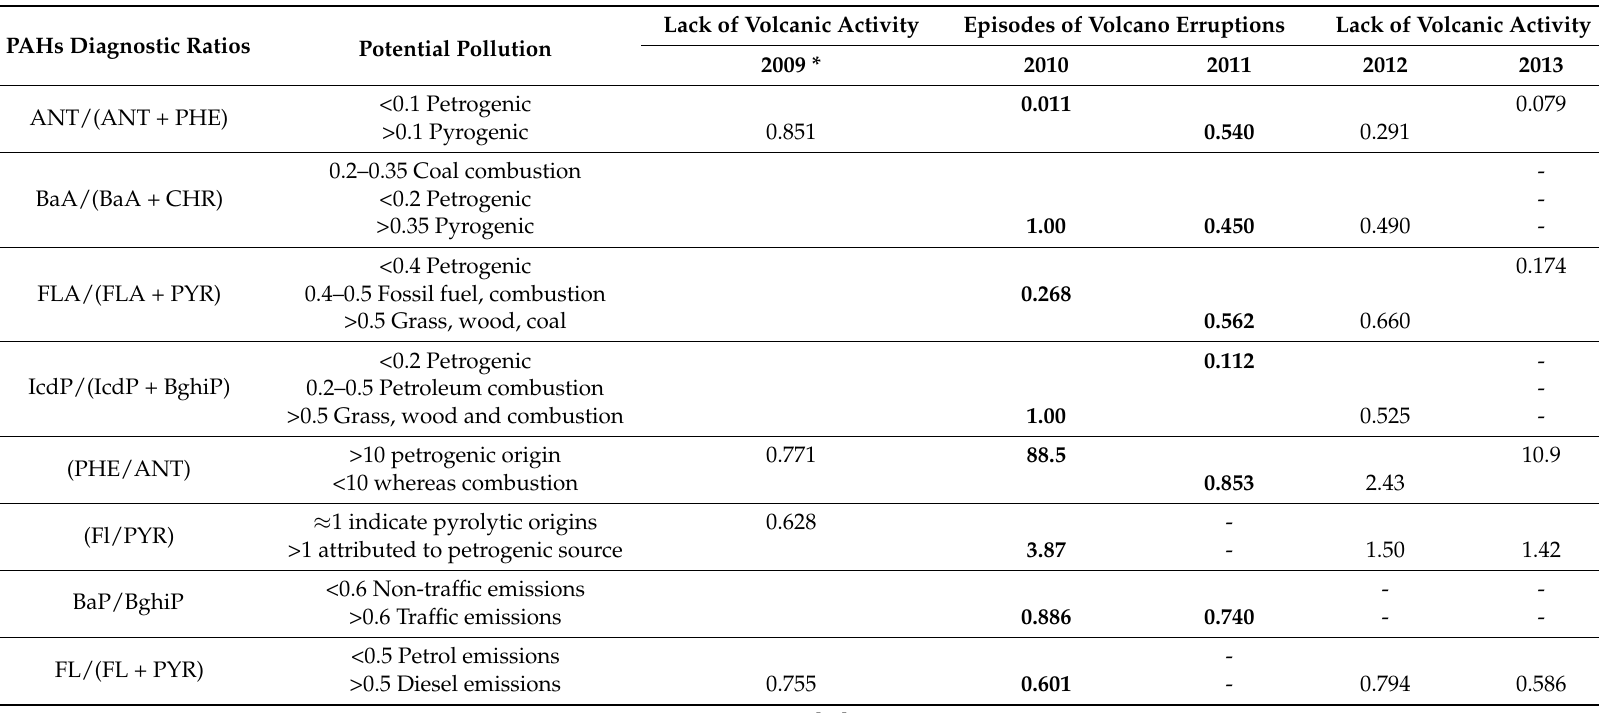
Table 5. Selected PAHs diagnostic ratios identified in water samples collected from the Fuglebekken catchment as compared to findings in